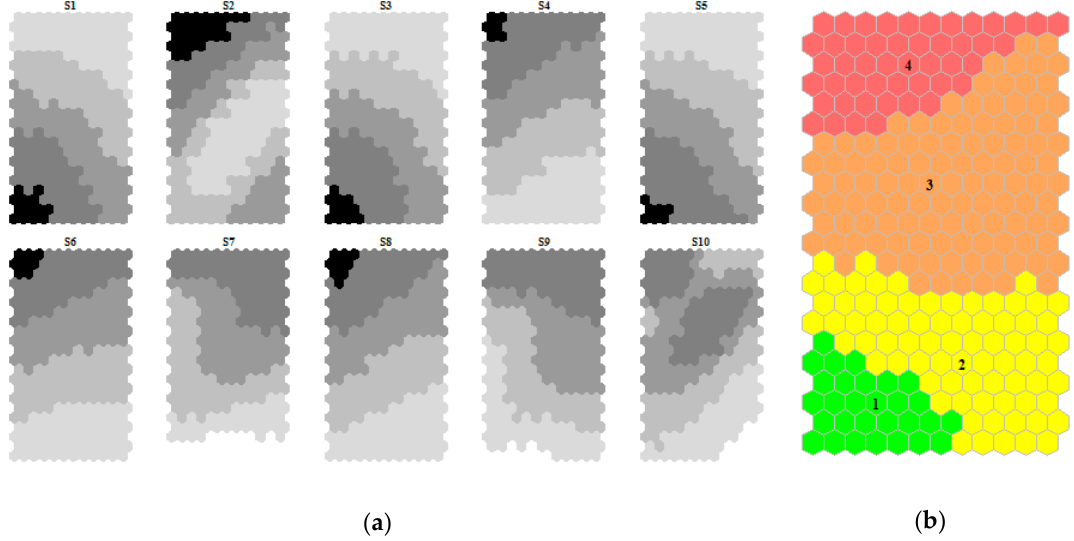
Figure 6. ( a ) Patterns of modeled responses of the ten sensors for the building data set as SOM planes. The grayscale indicates clear colors for low values to darker ones for high values and ( b ) localization of the cluster on the SOM.